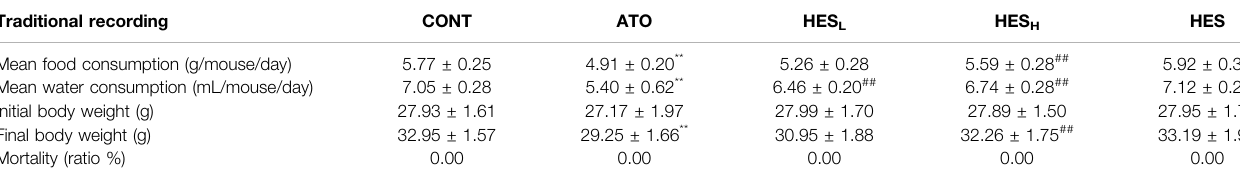
TABLE 1 | Summary of general observations in mice.